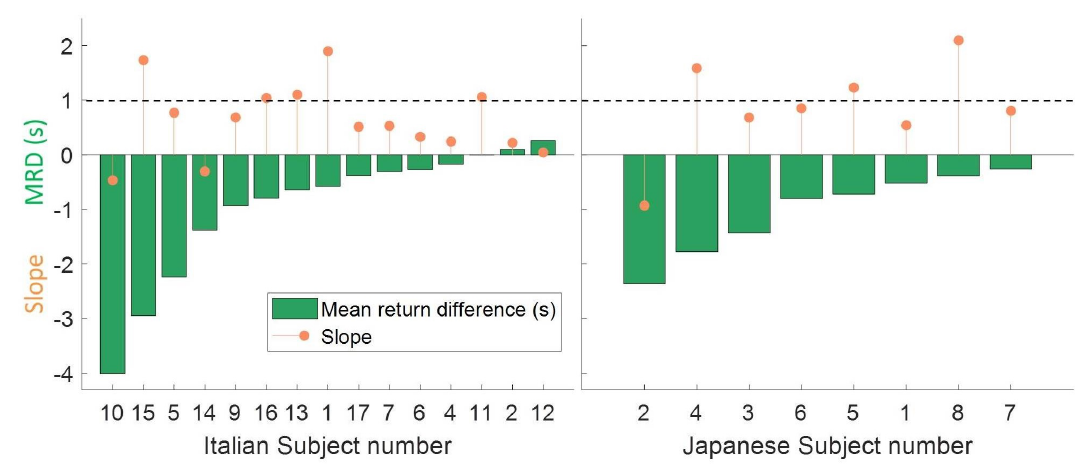
Figure 11: Stem plots represent the slope corresponding to the amount of adaptation of subjects. These slopes have been computed for the one-box condition, but those computed for the two-box condition are very similar. Bars represent the “Mean return difference” (MRD), that is the mean difference in timing between the instants in which the robot and the subject returned their hand to the starting position to get a new block. A negative value means that the subject arrived